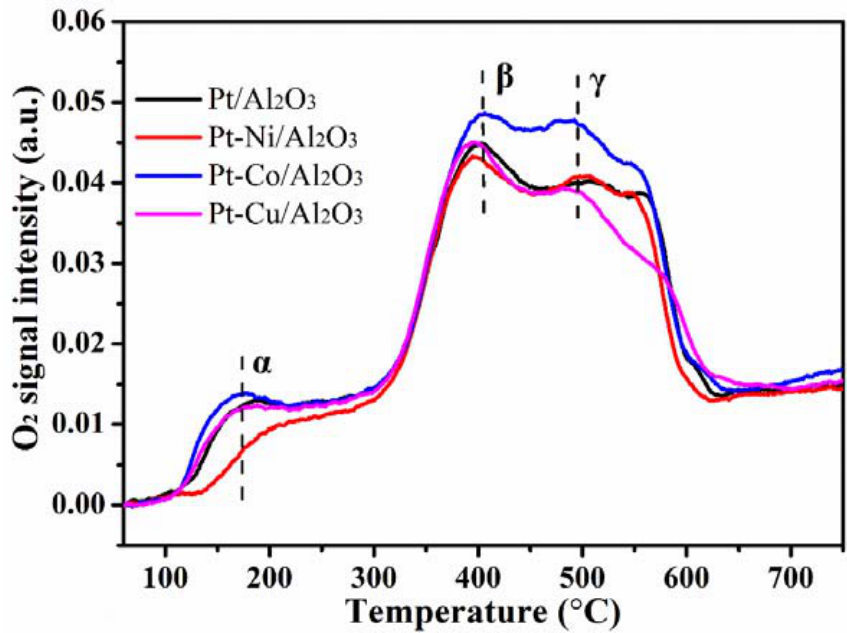
Figure 5. O 2 ‐ TPD profiles of these Pt/Al 2 O 3 and Pt ‐ M/Al 2 O 3